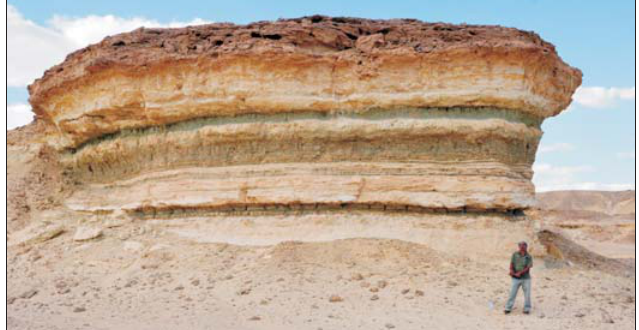
Fig. 5. Variegated layers in the lower part of the Oligocene sediments, right upon the BOTM at Minqar Tibaghbagh, Qattara Depression, Egypt. Point of view: E 26°26.380’, N